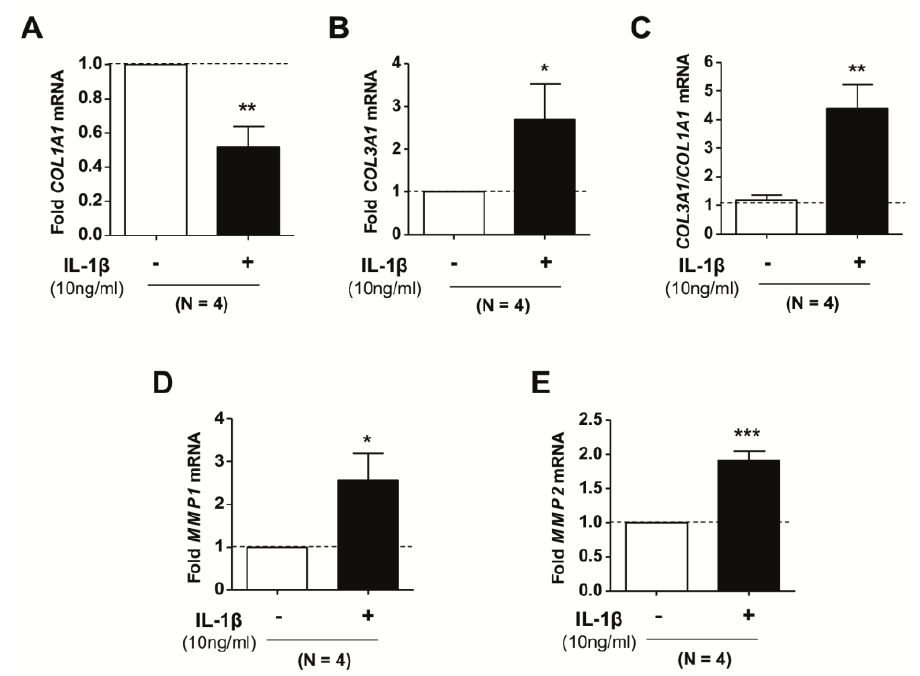
Figure 3. Expression of fibrillar collagens and major collagenases in primary pulmonary fibroblasts upon stimulation with 10 ng / mL IL-1 β for 72 h assessed by qRT-PCR. ( A , B ) mRNA levels of COL1A1 ( A ) and COL3A1 ( B ) in fibroblasts from randomly selected donors ( n = 4). ( C ) Corresponding COL3A1 / COL1A1 ratio. ( D , E ) mRNA levels of MMP1 ( D ) and MMP2 ( E ). Statistical analysis as in Figure 1, * p < 0.05, ** p < 0.01, *** p < 0.005.